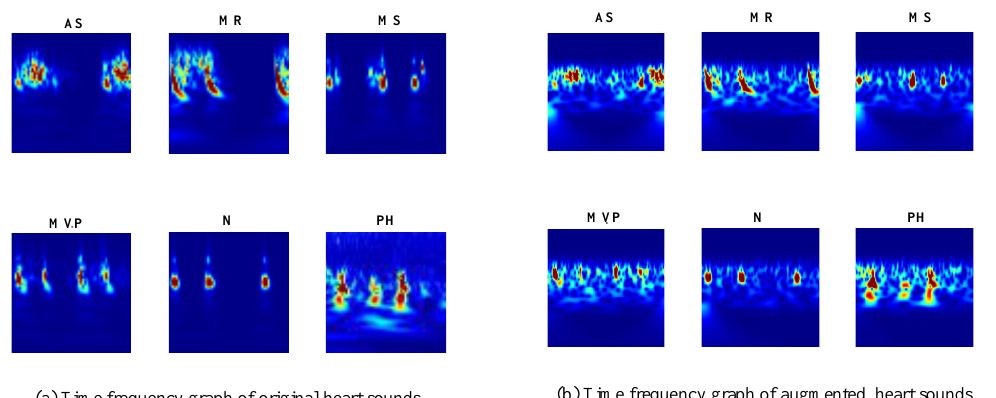
Figure 4. Time–frequency representation of PCG ( a ) time–frequency graphs of original heart sound Figure 4. Time – frequency representation of PCG ( a ) time – frequency graphs of original heart sound signals; ( b ) time–frequency graphs of the augmented heart sound signals. signals; ( b ) time – frequency graphs of the augmented heart sound signals.